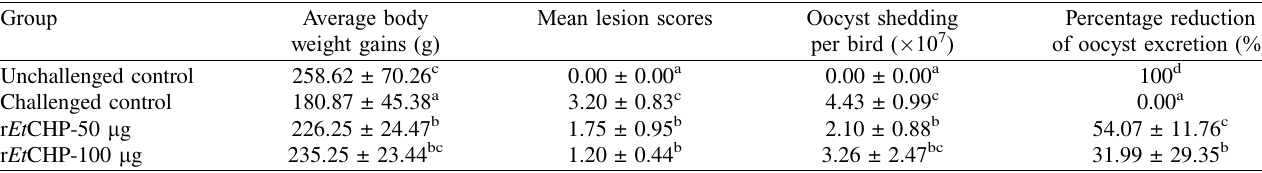
Table 1. Protective effect of r Et CHP protein on E. tenella infection.